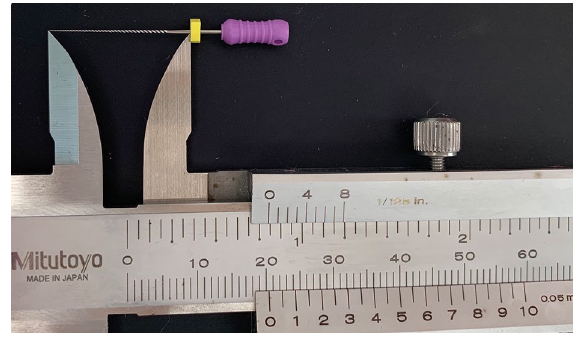
Figure 1. Actual length measurement with the